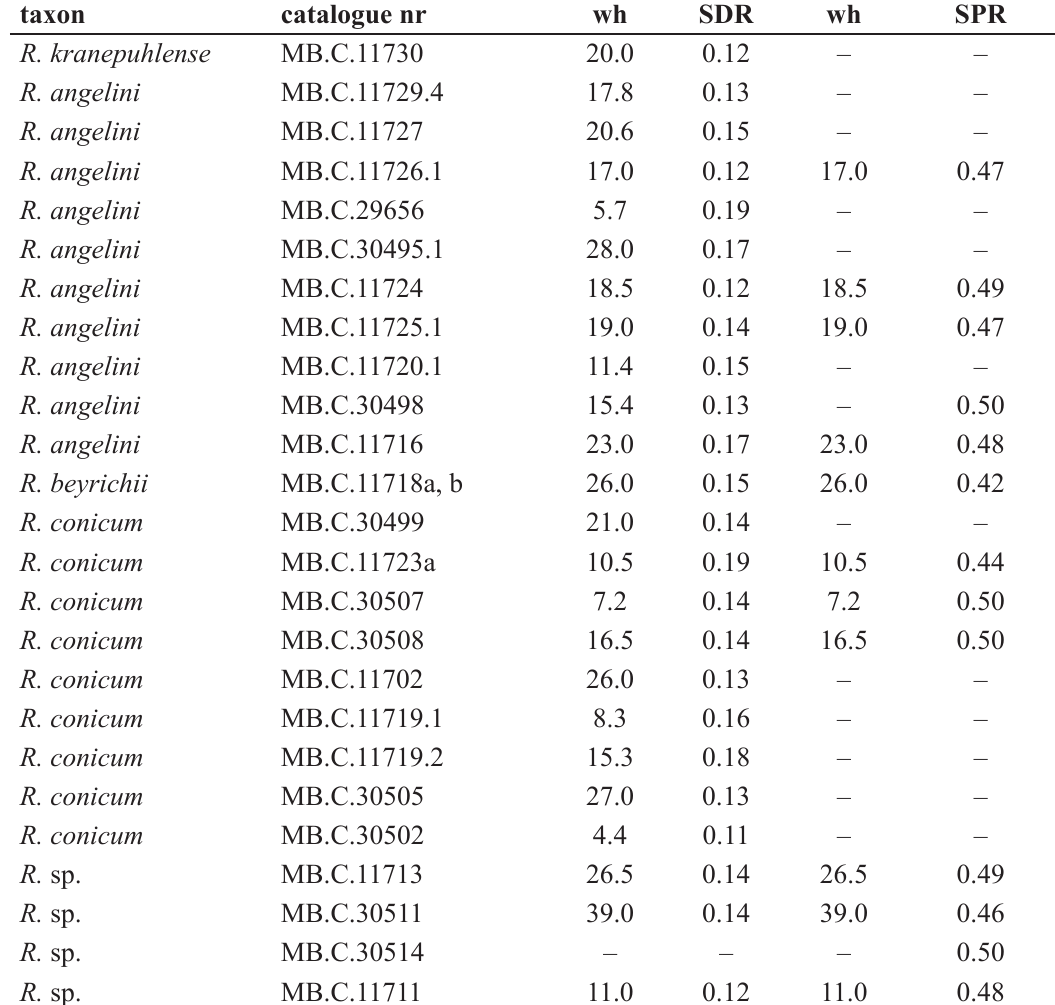
Table 3. Siphuncular diameter ratio (SDR) and siphuncular distance ratio (SPR) at their corresponding whorl height in specimens of Rhynchorthoceras Remelé,